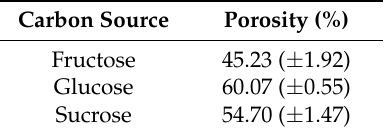
Table 2. Porosity of BC produced from different culture media.